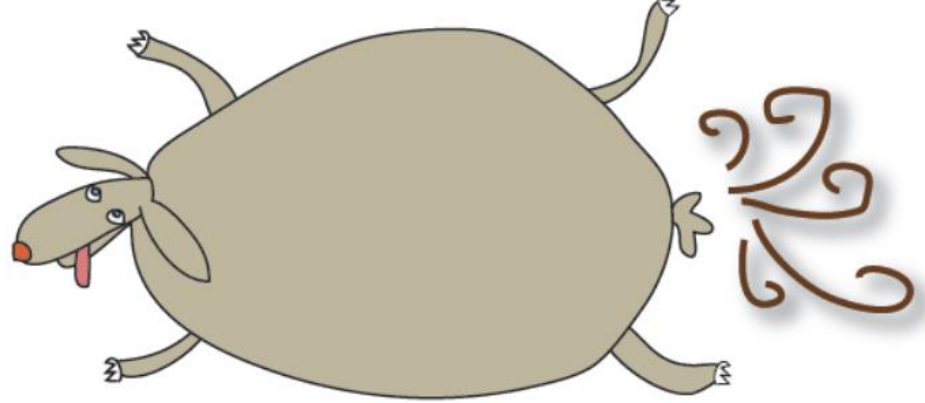
Figure 3. Tamara Schneider, Perro como una pelota . © 2017 Tamara Schneider. Used with permission.